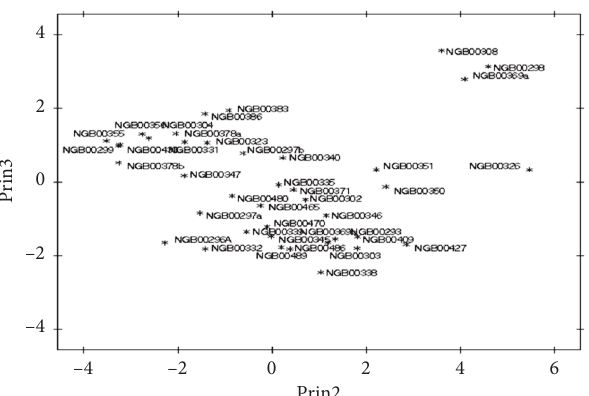
Figure 8: Configuration of the 40 okra genotypes under principal components 2 and 3.